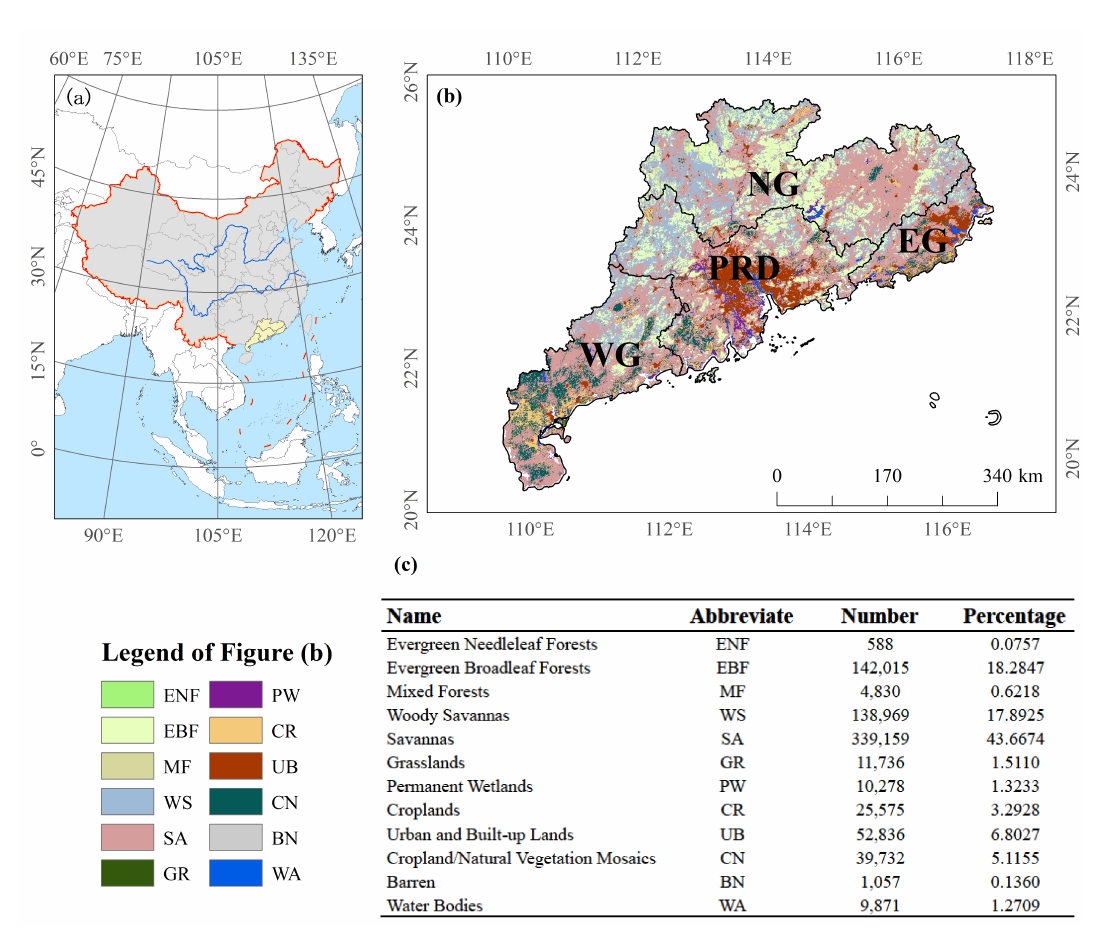
Figure 1. Map of the geographical location of China and southern China: ( a ) China’s administrative divisions map. PRD, WG, EG, and NG denote the Pearl River Delta, western Guangdong, eastern Guangdong, and northern Guangdong, respectively; ( b ) spatial distribution of land-use pluralities in southern China from 2001 to 2020; ( c ) statistics on the number and percentage of plural land-use types of